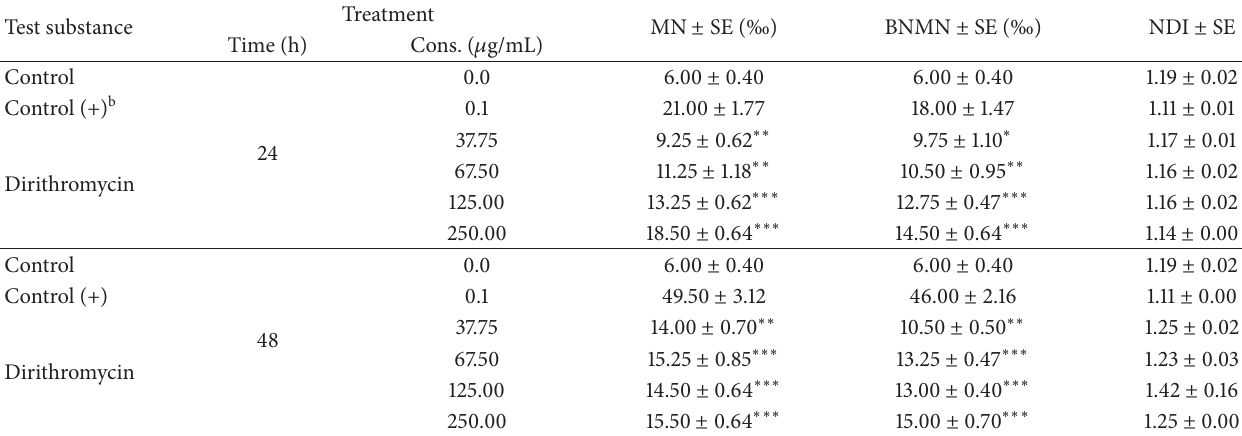
Table 3: Frequency of micronuclei (MNs), binucleated cells with MN (BNMN), and nuclear division index (NDI) in cultured human lymphocytes treated with dirithromycin and controls.